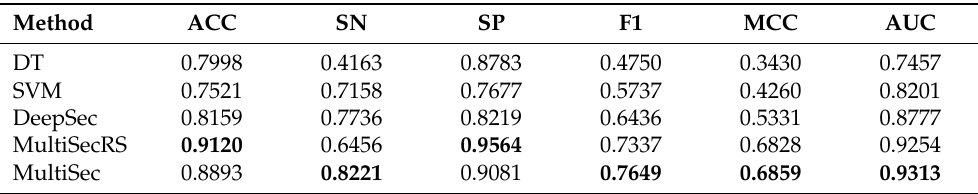
Table 3. Comparative average benchmarks of MultiSec and other approaches on the independent testing datasets of 14 human body fluids.